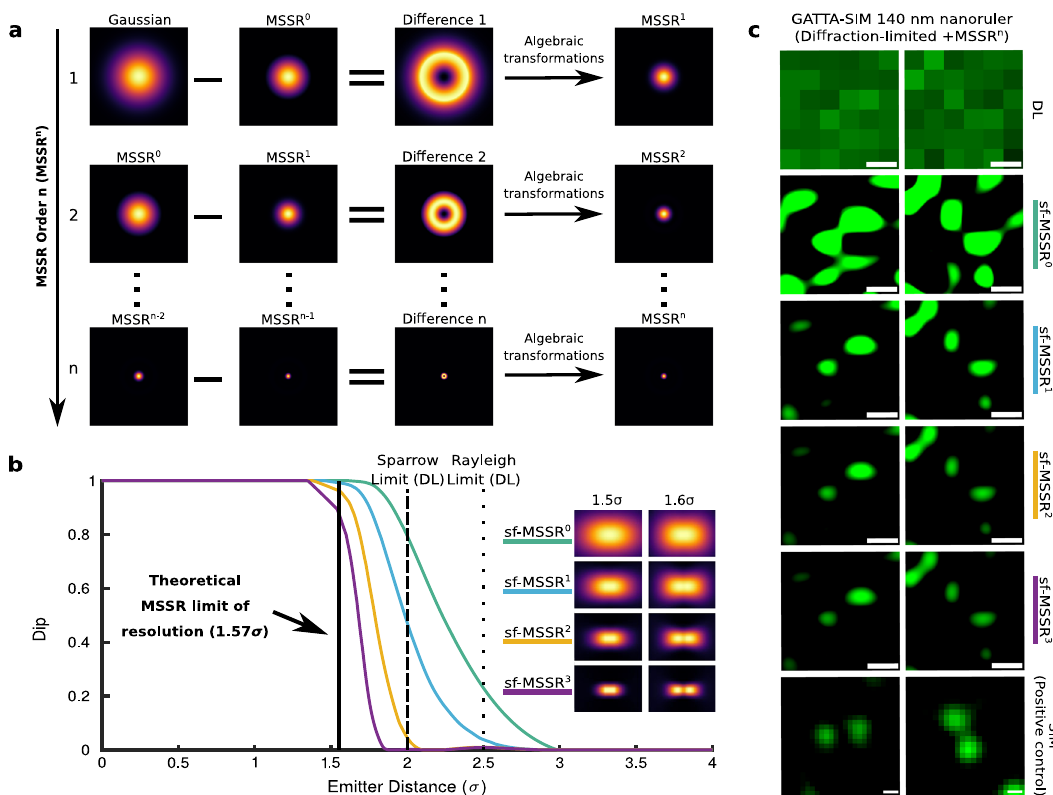
Fig. 2 | Single-frame MSSR analysis ofhigher order attains a resolutionlimitof 1.6 σ for nearby emitters. a Higher-order MSSR algorithm (MSSR n ). The fi rst iteration of MSSR (MSSR 1 ) is given by subtracting the MSSR 0 from the original image,resultinginadoughnut-likeregioncenteredattheemitter ’ slocation.MSSR 1 is computed after applying further algebraic transformations (see Supplementary Note 5 and Supplementary Fig. S11 (ii – iv) for a full description). The second itera- tion encompasses the subtraction of MSSR 1 from MSSR 0 and the same algebraic transformations as used for generation of MSSR 1 . The process is repeated by updating consecutive MSSR images which generates higher MSSR orders. b Theoretical limit of resolution achievable by MSSR n . Dip computed for two Gaussian emitters in accordance with the variation of the inter-emitter distance (expressed as σ -times their standard deviation before MSSR processing). Colored lines represent the dip of MSSR order,from 0 to 3, computed ata given σ distance